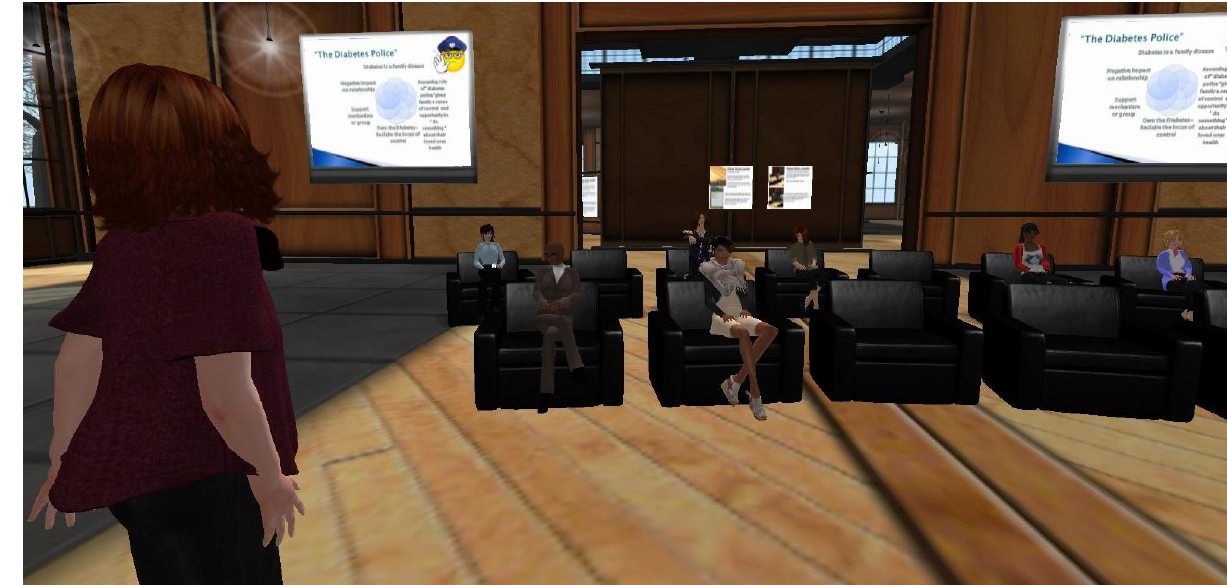
Figure 1. Class session in